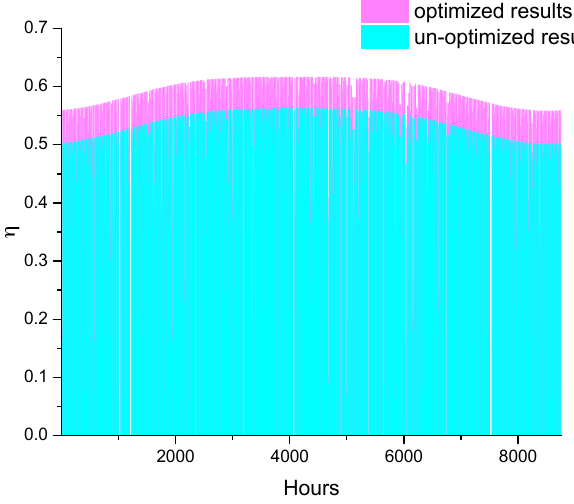
Figure 4. The heliostat field efficiency of the whole year.